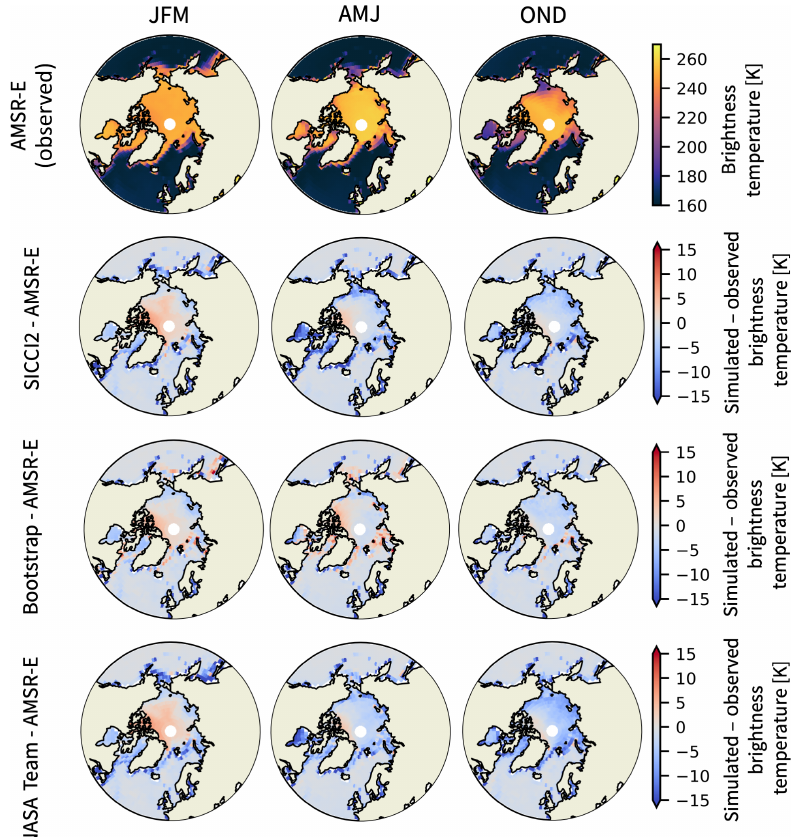
Figure 4. Observed brightness temperatures by AMSR-E (top row). Differences between brightness temperatures simulated with ARC3O from MPI-ESM output assimilated with SICCI2 (second row), Bootstrap (third row), and NASA Team (bottom row) sea ice concentration and observed brightness temperatures. The columns stand for the three cold seasons: JFM, AMJ, and OND. Summer (JAS) is discussed in Sect.